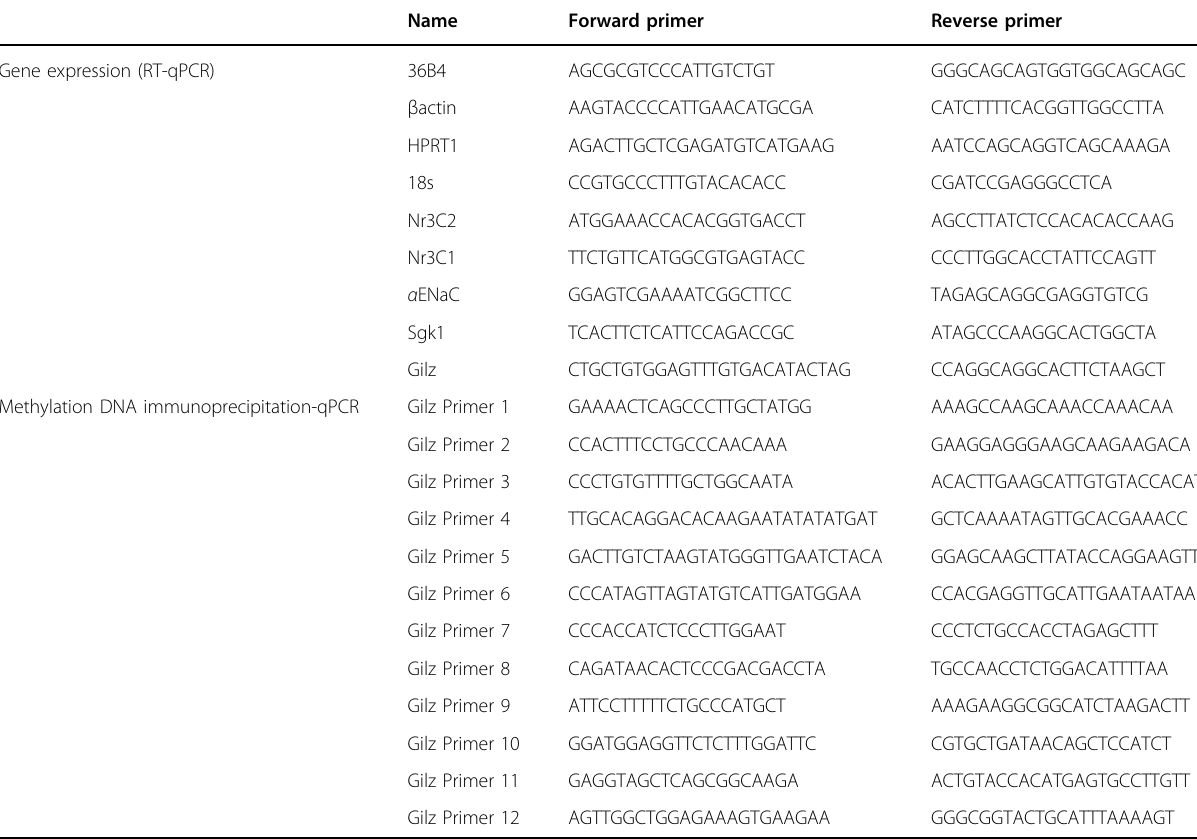
Table 1 Primers used to determine the relative expression of corticosteroid signaling pathway genes and housekeeping genes by RT-qPCR and to quantify DNA immunoprecipitation of Gilz by